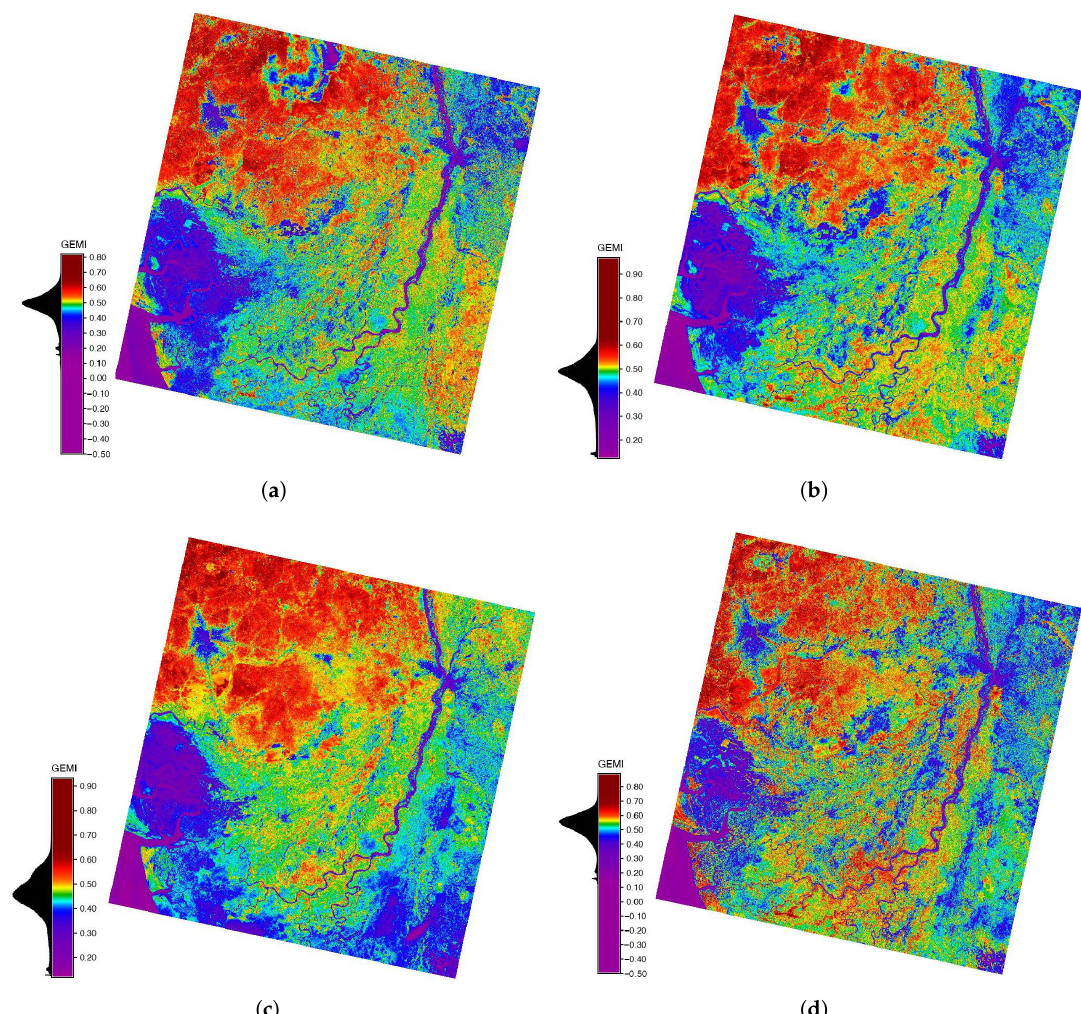
Figure 8. GEMI computed from the Landsat 8-9 OLI/TIRS images of Niger River Delta for four years: ( a ) 2013, ( b ) 2015 ( c ) 2021, ( d )